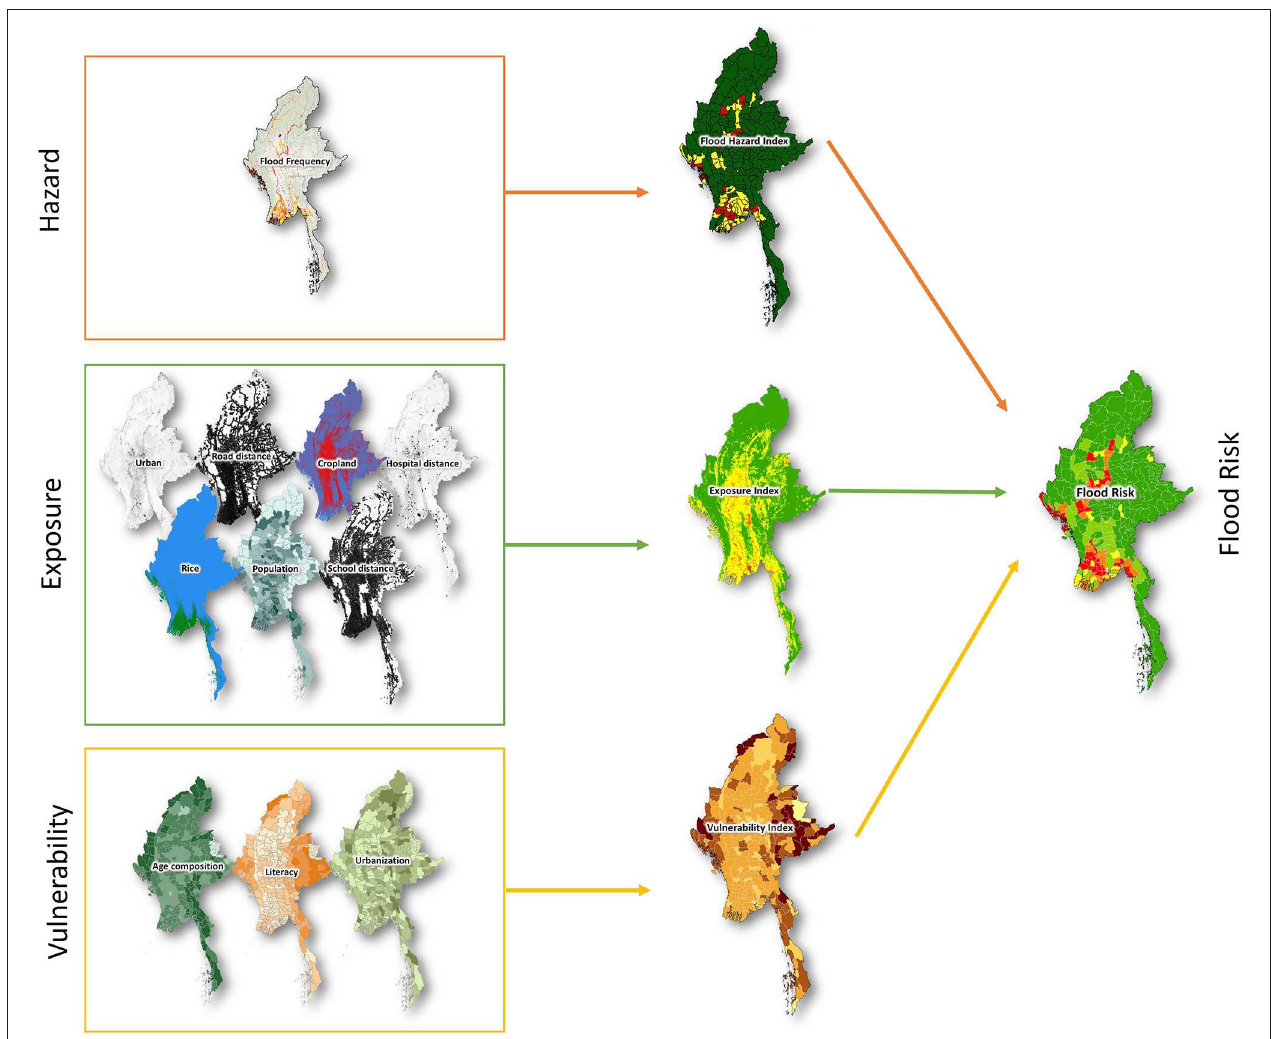
FIGURE 2 | Schematic overview of how the indices on Hazard, Exposure, and Vulnerability are combined into the flood risk index.